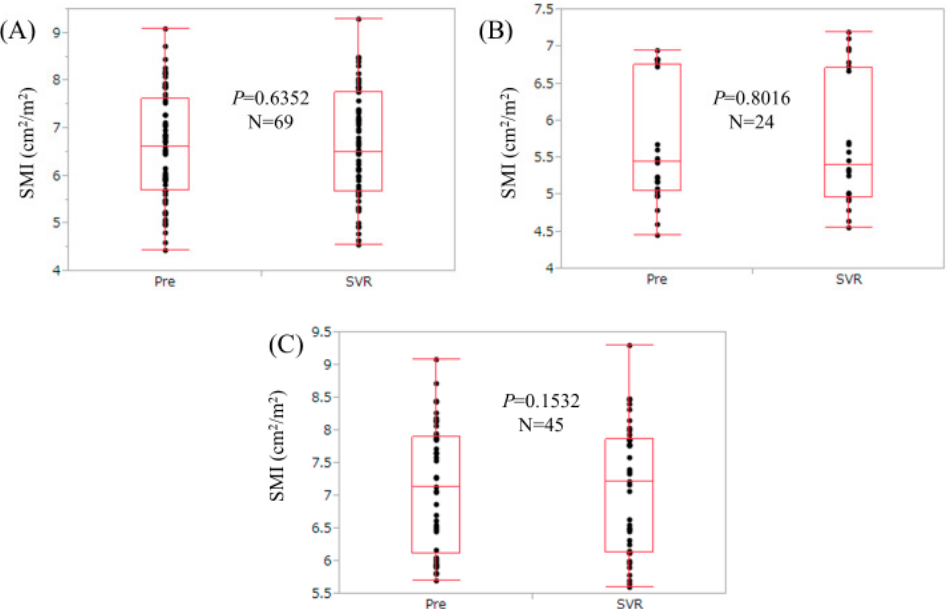
Figure 1. Changes in skeletal muscle index (SMI) during interferon (IFN)-free direct acting antivirals (DAAs) therapy at pretreatment and sustained virological response (SVR). ( A ) For the entire cohort ( n = 69); ( B ) For patients with low muscle mass at baseline ( n = 24, as defined by current guidelines [11]); ( C ) For patients without low muscle mass at baseline ( n = 45, as defined by current guidelines [11]).